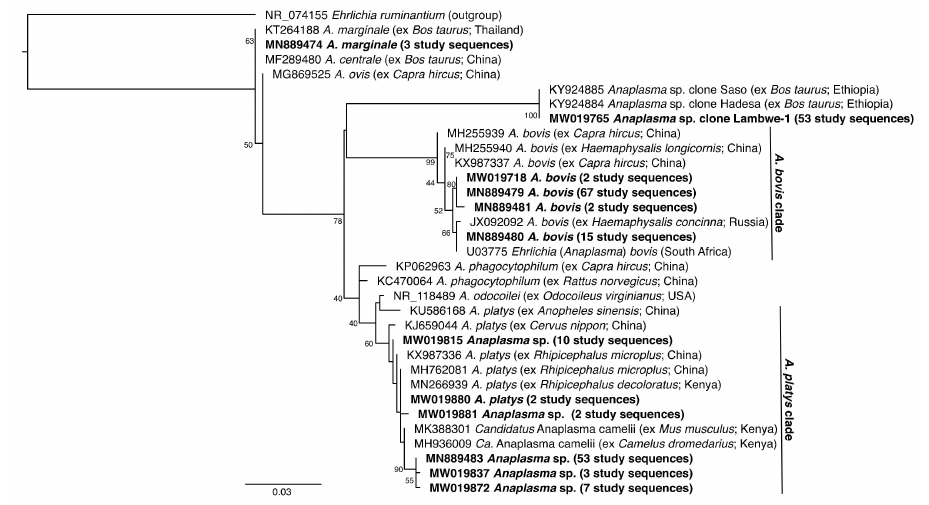
Figure 3. Maximum likelihood phylogeny of 810-bp Anaplasma 16S rRNA sequences from cattle blood samples. GenBank accession numbers, species, host species, and country of origin are indicated for each reference 16S rRNA gene sequence. Sequences obtained in this study are highlighted in bold with the number of samples with specific pathogen sequence identified indicated in brackets. The tree is rooted using the Ehrlichia ruminantium sequence as an outgroup. Bootstrap values at the major nodes represent percent agreement among 1000 replicates. The branch-length scale represents substitutions per